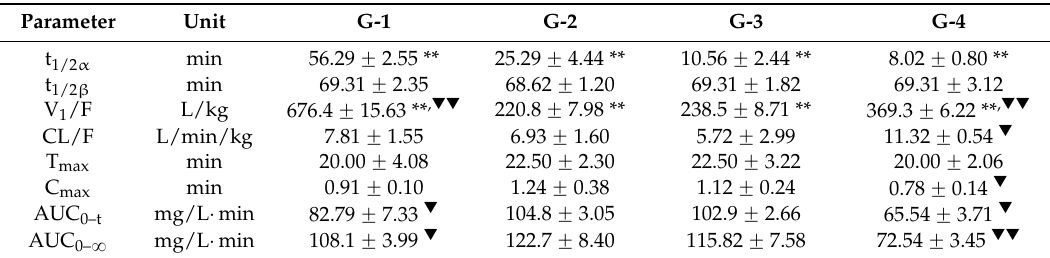
Table 2. Pharmacokinetic parameters of daidzin after rabbit stomachs were perfused with four kinds of GGD of dosage equal to 0.82 g/kg ( n = 4, x ˘ sd ) R